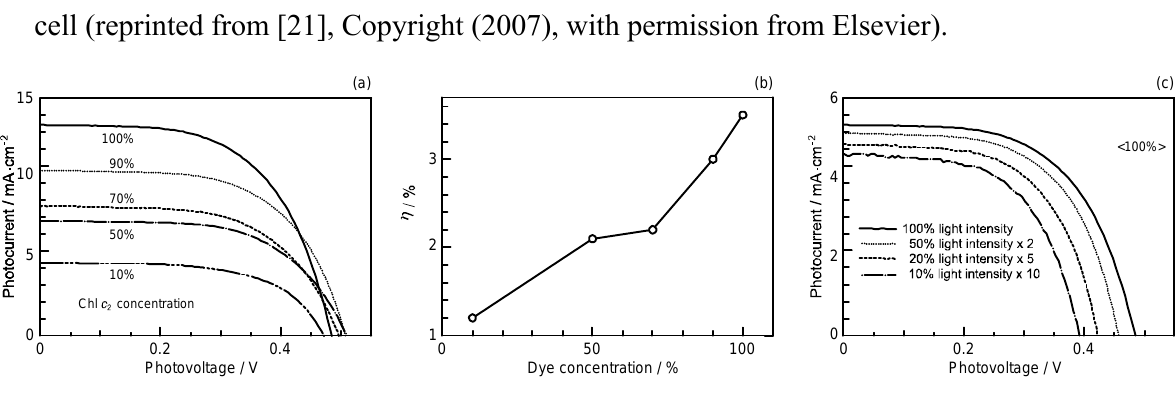
-sensitized solar 2